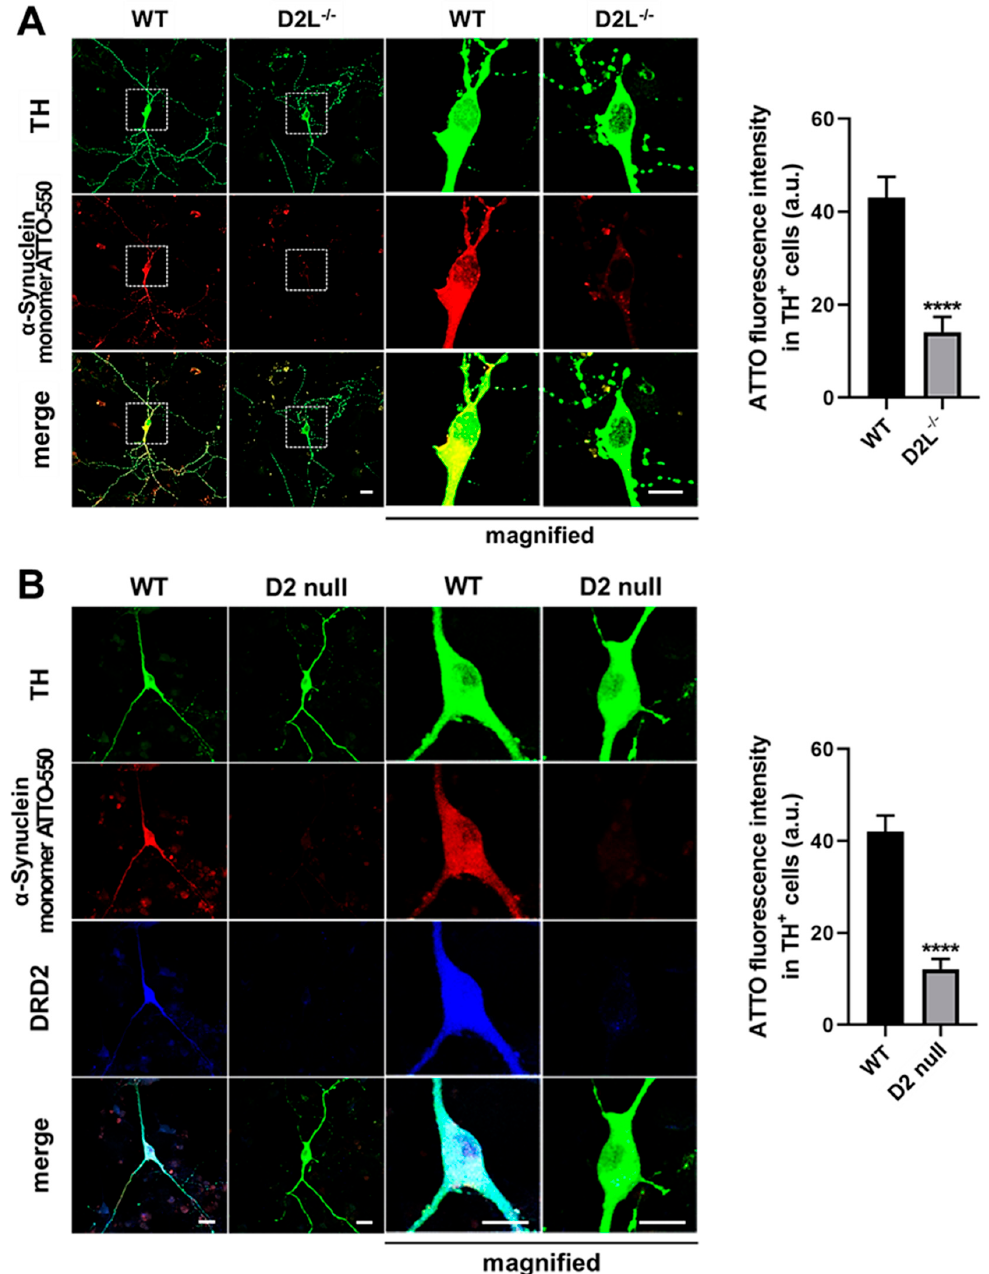
Figure 3. Cultured dopaminergic neurons require dopamine D2 receptors to take up α -synuclein. ( A ) Representative images of TH + mesencephalic neurons at 12 days in vitro (DIV) derived from wild type (WT) or D 2L − / − C57BL6 mice. Neurons were treated with 1 µ M ATTO-550-labeled α -synuclein monomer for 48 h and stained with anti-TH antibody (TH, green). The magnified images were enlarged by three times. Scale bar 10 µ m. The right graph shows the quantitative analysis of ATTO-550-labeled α -synuclein monomer fluorescence intensity of individual TH + neurons. **** p < 0.0001 in wild type (WT) versus D 2L − / − , n = 34 in three independent experiments. ( B ) Representative images of TH + mesencephalic neurons derived from wild type or D2 null knockout mice. Neurons were treated with ATTO-550-labeled α -synuclein monomer in the same condition as in ( A ) and stained with anti-TH antibody (TH, green) and dopamine D2 receptor (DRD2, blue). The magnified images were enlarged by three times. Scale bar 10 µ m. The quantitative analysis of ATTO-550-labeled α -synuclein monomer fluorescence intensity of individual TH + neurons on the right. **** p < 0.0001 in WT versus D2 null knockout (D2 null), n = 28 in three independent